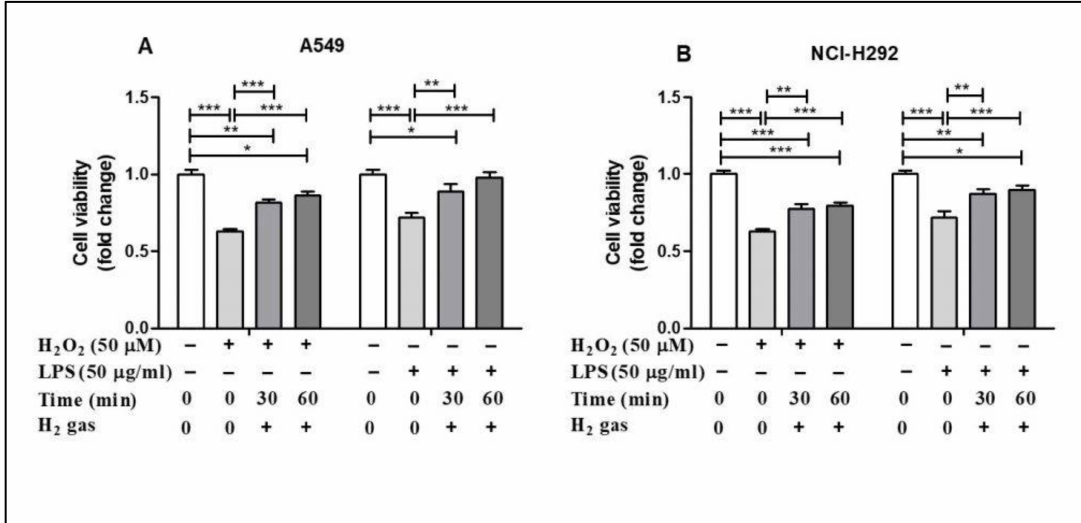
Figure 2. Effect of 2% H 2 gas on cell viability in A549 and NCI-H292 cells induced with H 2 O 2 and LPS. Effect of H 2 gas (30 min and 60 min post-treatment) on the viability of ( A ) A549 cells induced with H 2 O 2 (50 µ M) and LPS (50 µ g/mL) and ( B ) NCI-H292 cells induced with H 2 O 2 (50 µ M) and LPS (50 µ g/mL). Data are presented as mean ± SEM. * p < 0.05, ** p < 0.01 and *** p < 0.001 represent significant differences based on